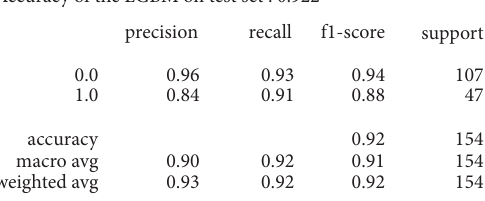
Figure 15: Light gradient boosting classifer. Table 2: Results after data augmentation.